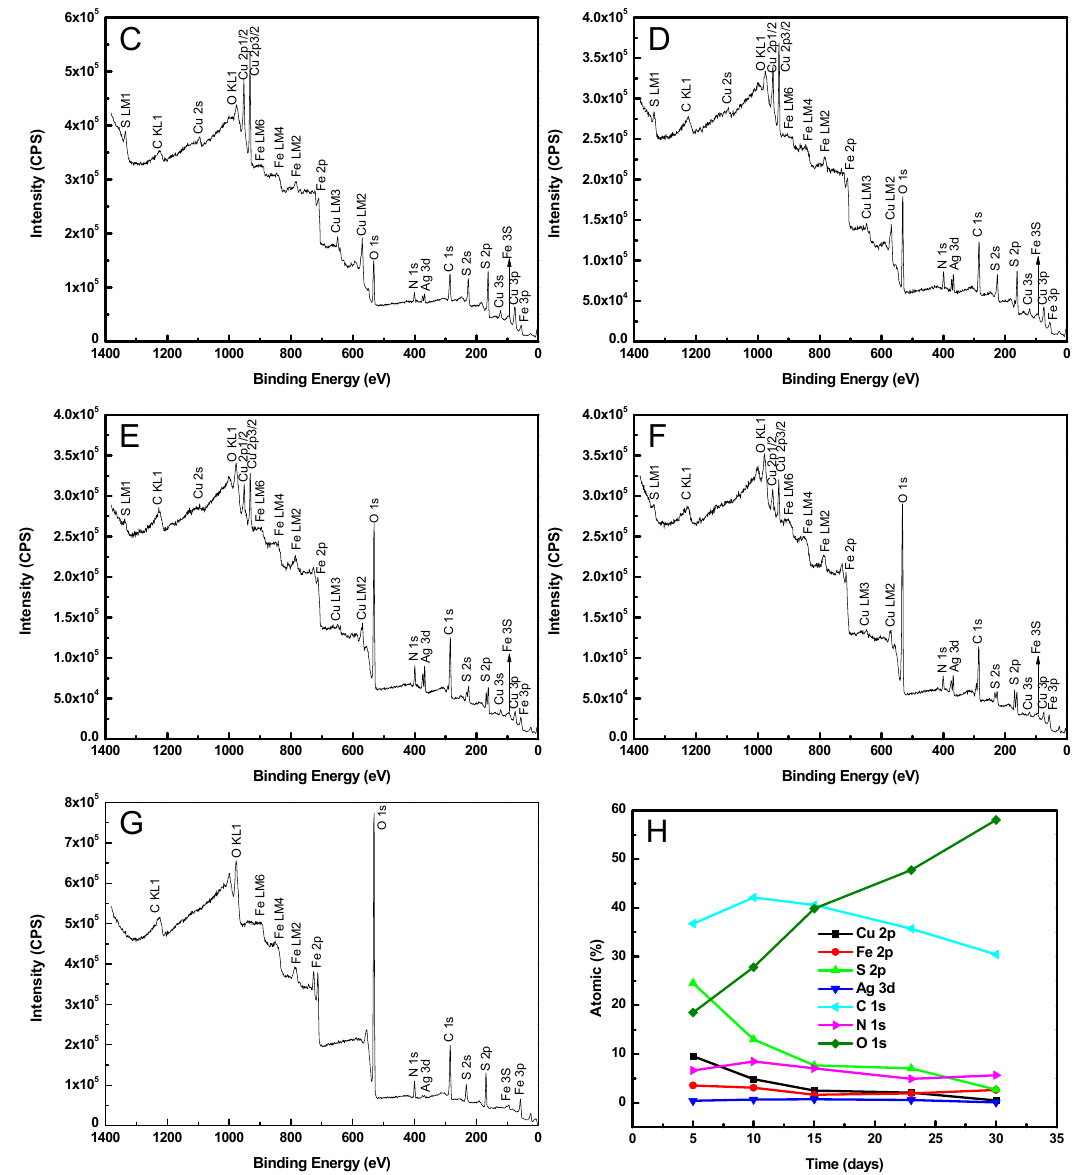
Figure 3. Survey (full range) X-ray photoelectron spectroscopy (XPS) spectra of co-bioleaching of chalcopyrite and bornite (ratio of Ccp/Bn was 3:1). ( A ) chalcopyrite; ( B ) bornite; ( C ) 5 days; ( D ) 10 days; ( E ) 15 days; ( F ) 23 days; ( G ) 30 days. H-Change in atomic percentages on the surface of residues during the bioleaching process. Data source: survey (full range) XPS spectrum. High-resolution spectra of Cu 2p for bornite, chalcopyrite, and leaching residues are shown in Figure 4. It is well established in literature that the high binding energy (in the range of 933.0 to 933.8 eV) and the presence of a satellite peaks (around 942 eV) are two main XPS characteristics of Cu(II), while a lower binding energy (in the range of 931.8 to 933.1 eV) and the absence of satellite peaks are characteristics of Cu(I) and metal Cu [14,51–53]. From Figure 4, it can be seen that the oxidation state for Cu after bioleaching was still +1. Although low-intensity peaks of chalcopyrite were detected by XRD after 30 days of bioleaching, no Cu peak was detected by XPS. This may be because the chalcopyrite was covered by jarosite and elemental sulfur (Figure 2F).